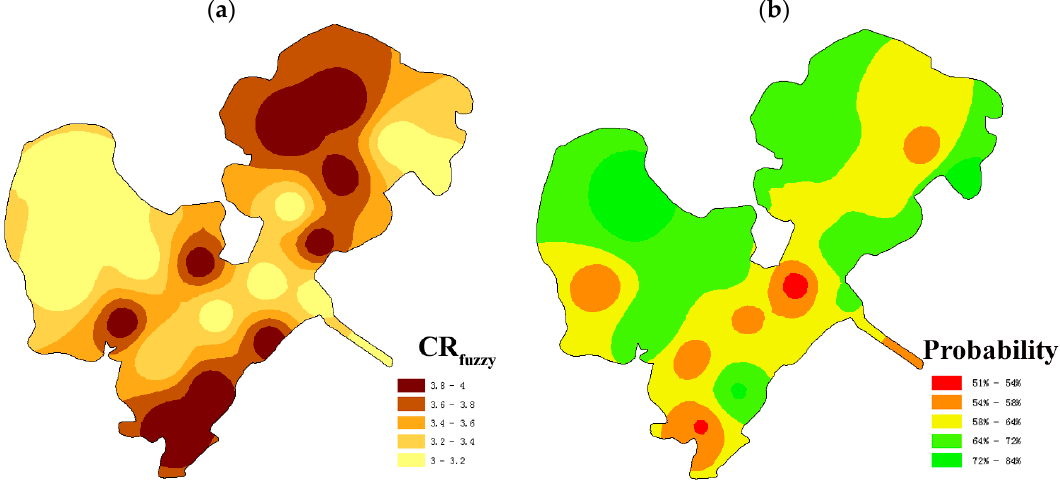
Figure 4. Integrated carcinogenic risk levels based on fuzzy assessment ( a ) and its corresponding probability subjection ( b ) of surface water from Honghu Lake.